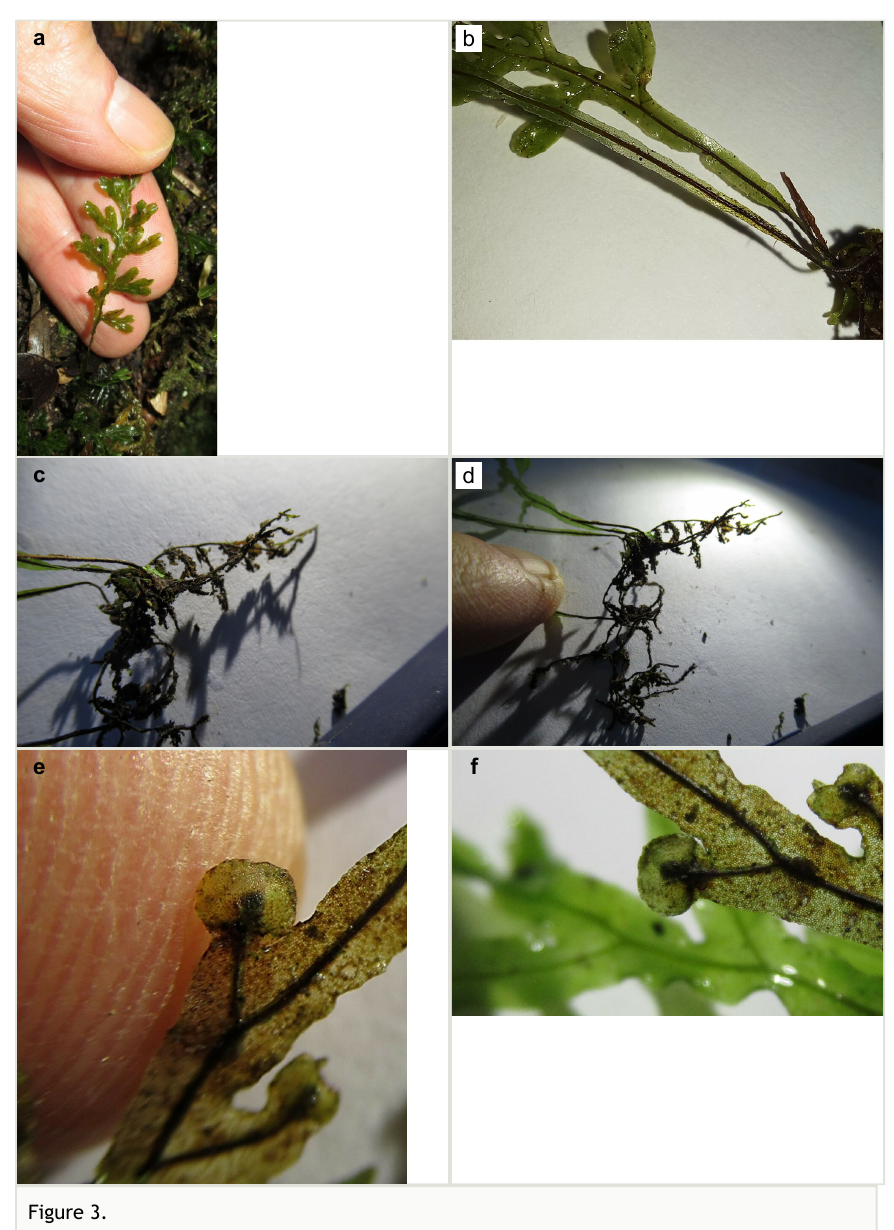
Figure 3. Specimen of H. caudatum